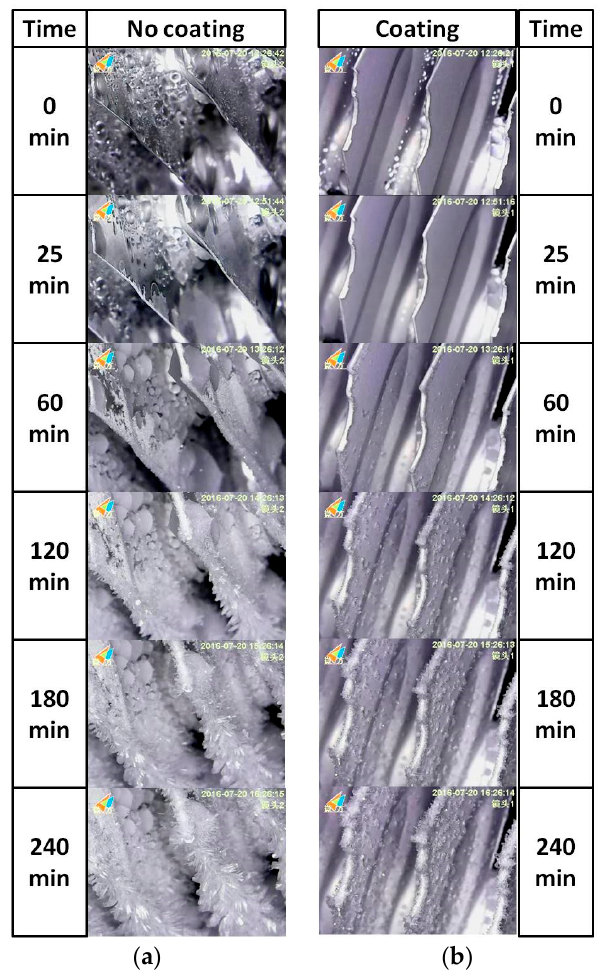
Figure 7. Frost formation process and variation of frost mass with time for various surfaces after defrosting. ( a ) Normal surfaces; ( b ) PDMS-SiO 2 /SS hybrid coated surfaces.